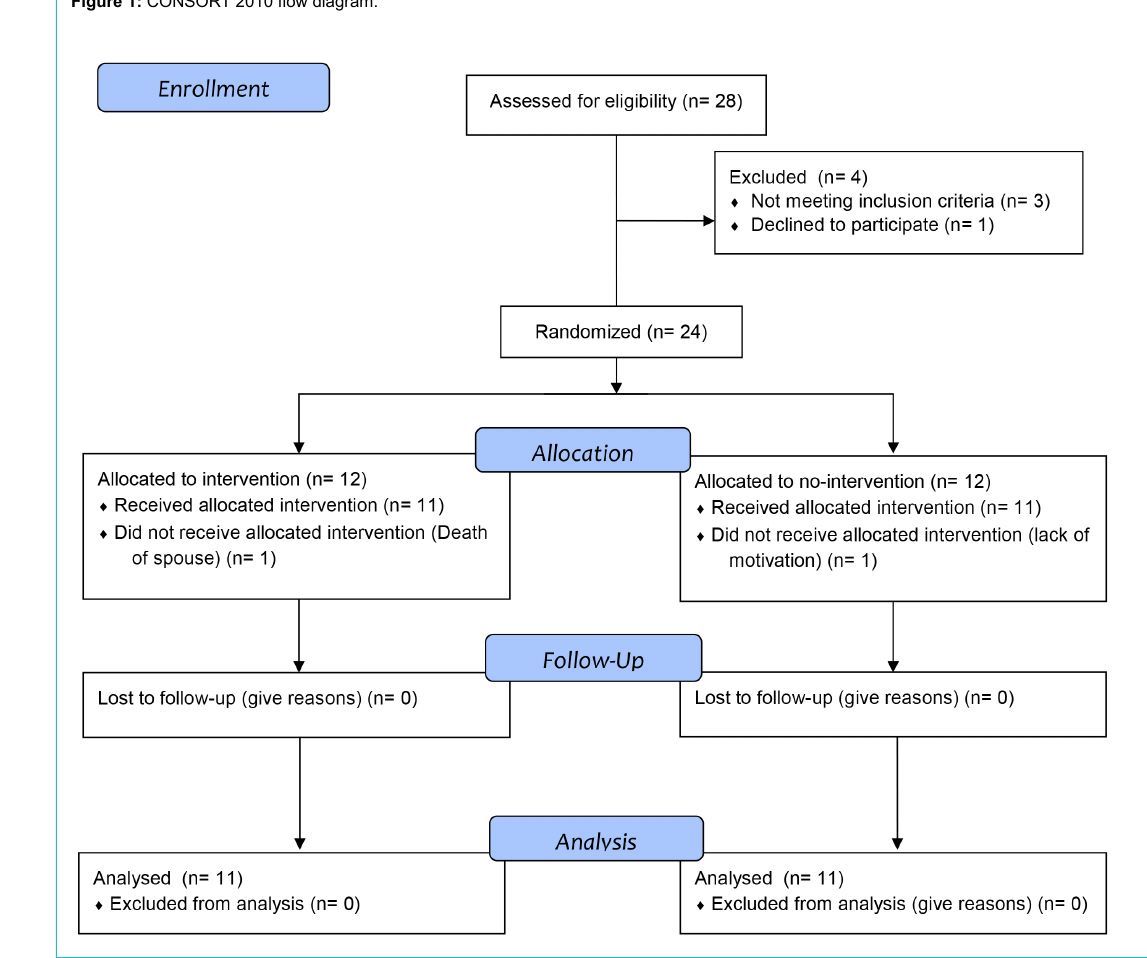
Figure 1: CONSORT 2010 flow